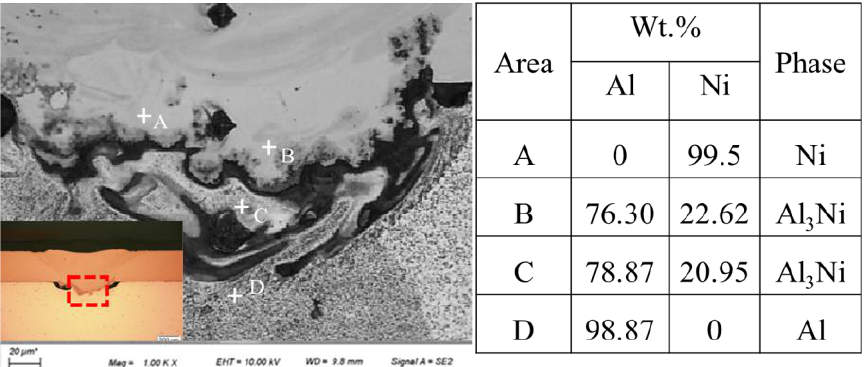
Figure 7. SEM image with high magnification, EDS results in areas A – D of the Al-Ni joint welded using PW laser with 120 W laser power.